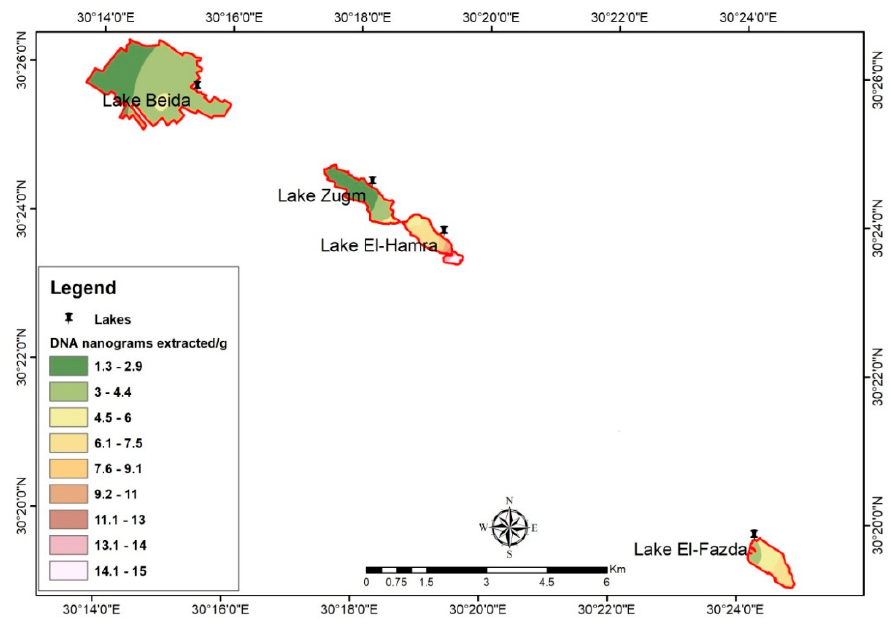
Figure 8. Spatial distribution by GIS of DNA (ng/g) extracted from sediment/salt crystal samples of Wadi El-Natrun soda lakes.